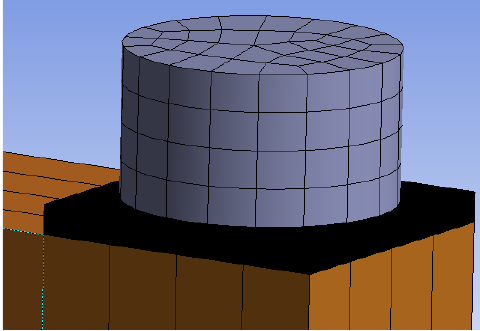
Figure 9. Finite element mesh for applying load.